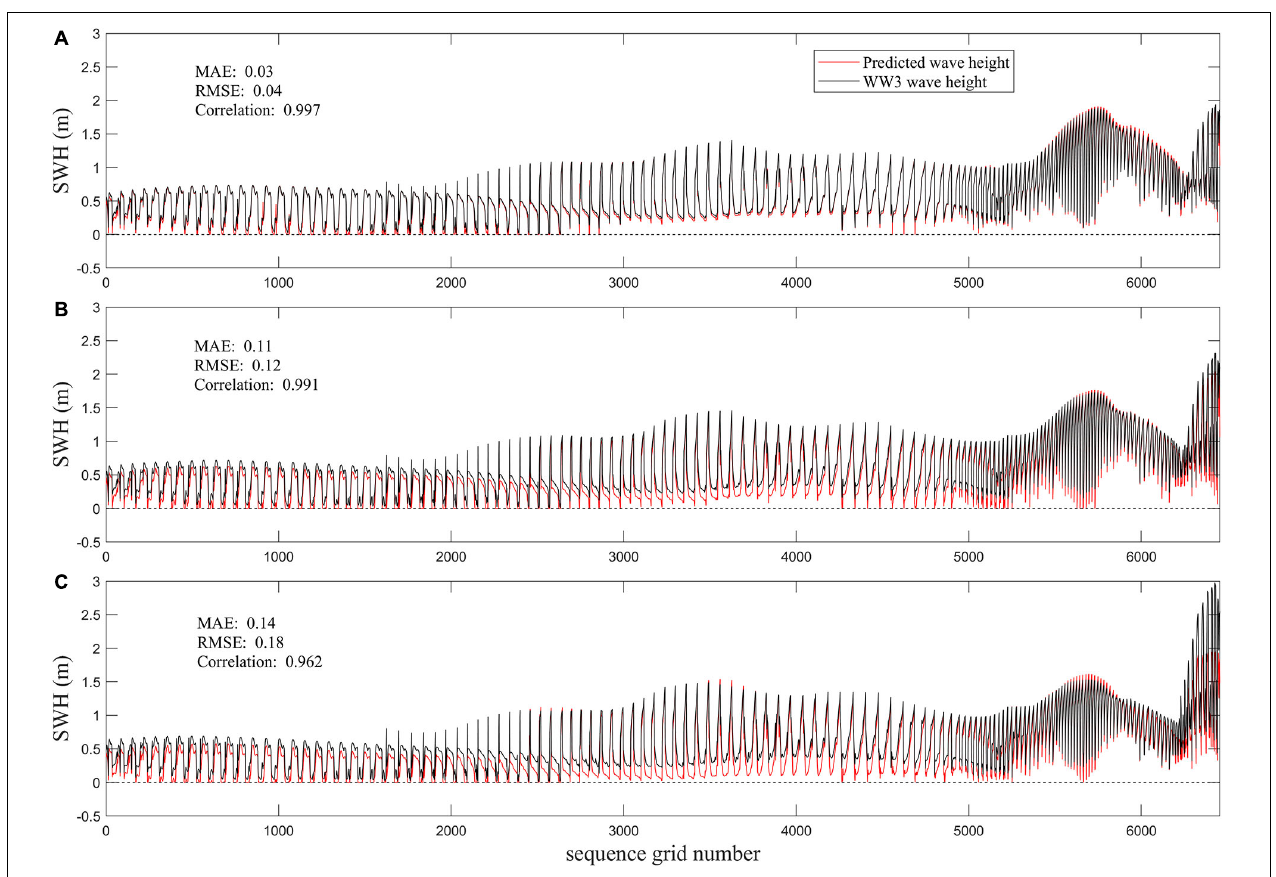
FIGURE 3 | Predicted (red line) vs. the WW3 (black line) SWH throughout the study area for (A) 1-, (B) 3-, and (C) 6-h forecast moments.